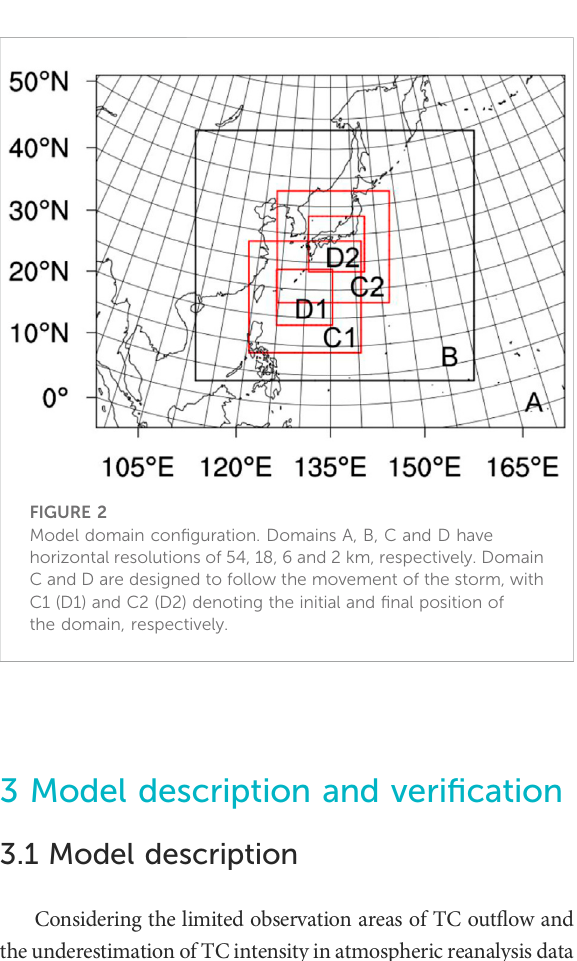
at horizontal resolutions (grid points) of 54 km (172 × 130), 18 km Figure 2. The simulations start at 0000 UTC 18 September 2011 and end at 0000 UTC 21 September 2011 in all four domains, with an integration period of 72 h, covering the RI process of Typhoon Roke (2011). The outer domains A and B are stationary, while the inner domains C and D move with the center of Roke (2011) at a 15-min interval, where C1 (D1) and C2 (D2) denote the initial and fi nal positions of the domain C (D), respectively (Figure 2). The outermost domain A is suf fi ciently large to cover the region of the out fl ow-environment interaction. In the innermost domain D, the TC inner-core characteristics can be captured at a high resolution. The model initial and lateral boundary conditions in domain A are derived from the interpolation of the National Centers for Environmental Prediction Final Operational Global Analysis (FNL) data, which has spatio-temporal resolutions of 1 ° × 1 ° and 6 h. The NCEP FNL analysis is based on the Global Data Assimilation System (GDAS), which continuously collects observational data from the Global